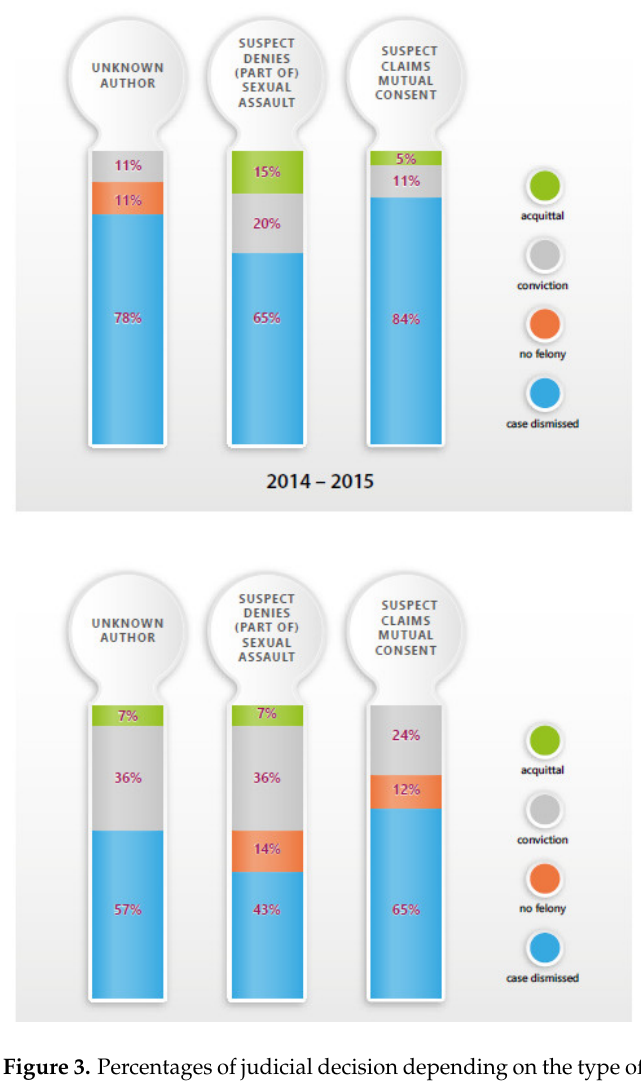
Figure 3. Percentages of judicial decision depending on the type of DFSA for reference year